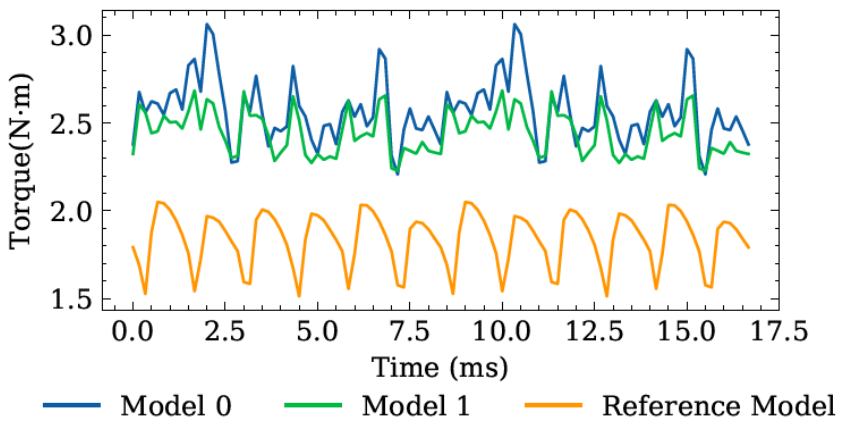
Figure 14. Comparison of torque performance among Model 0, Model 1, and reference model.